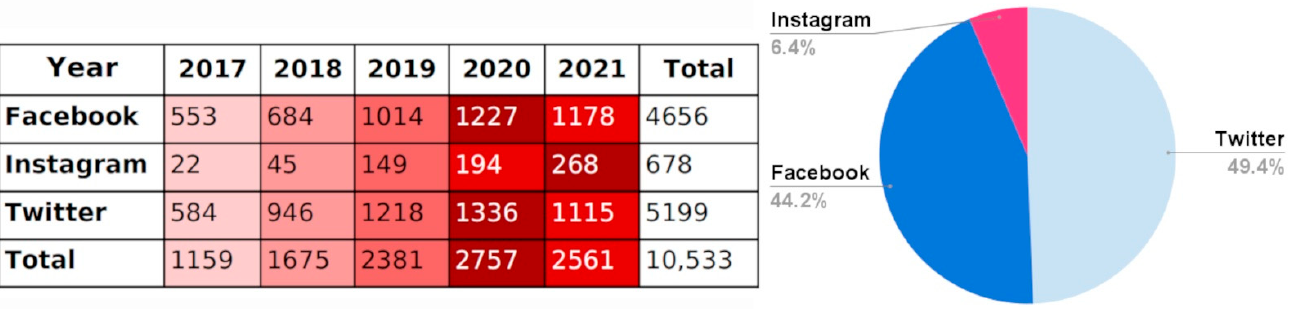
Figure 2. Total number of posts filtered for each network according to the object of study.